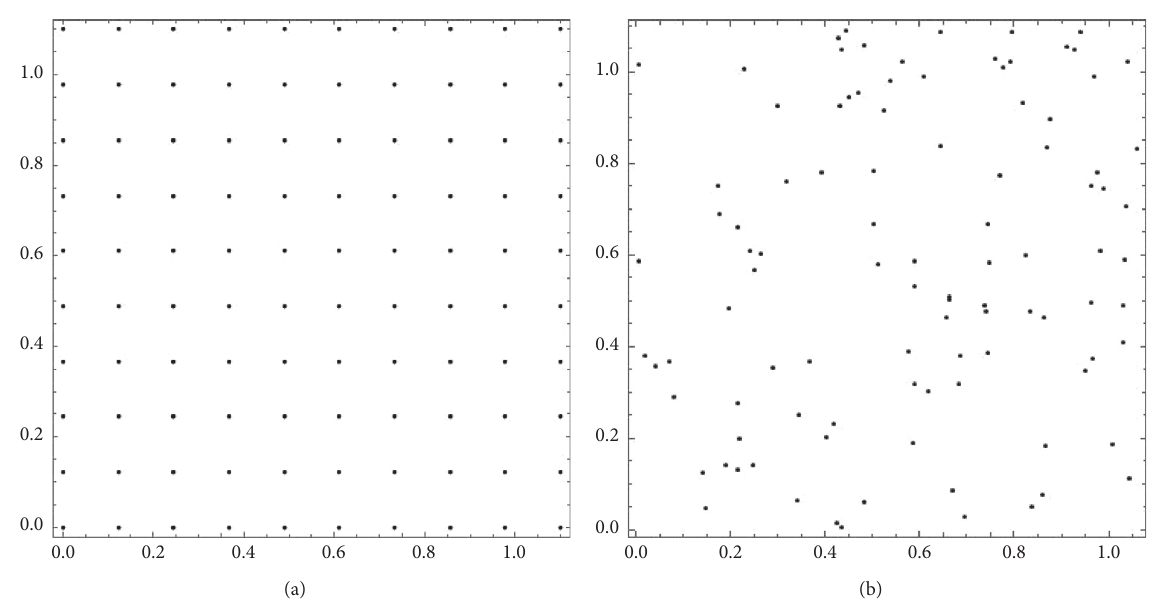
Figure 1: (a) The mesh points. (b) The meshless points. There are 100 points for